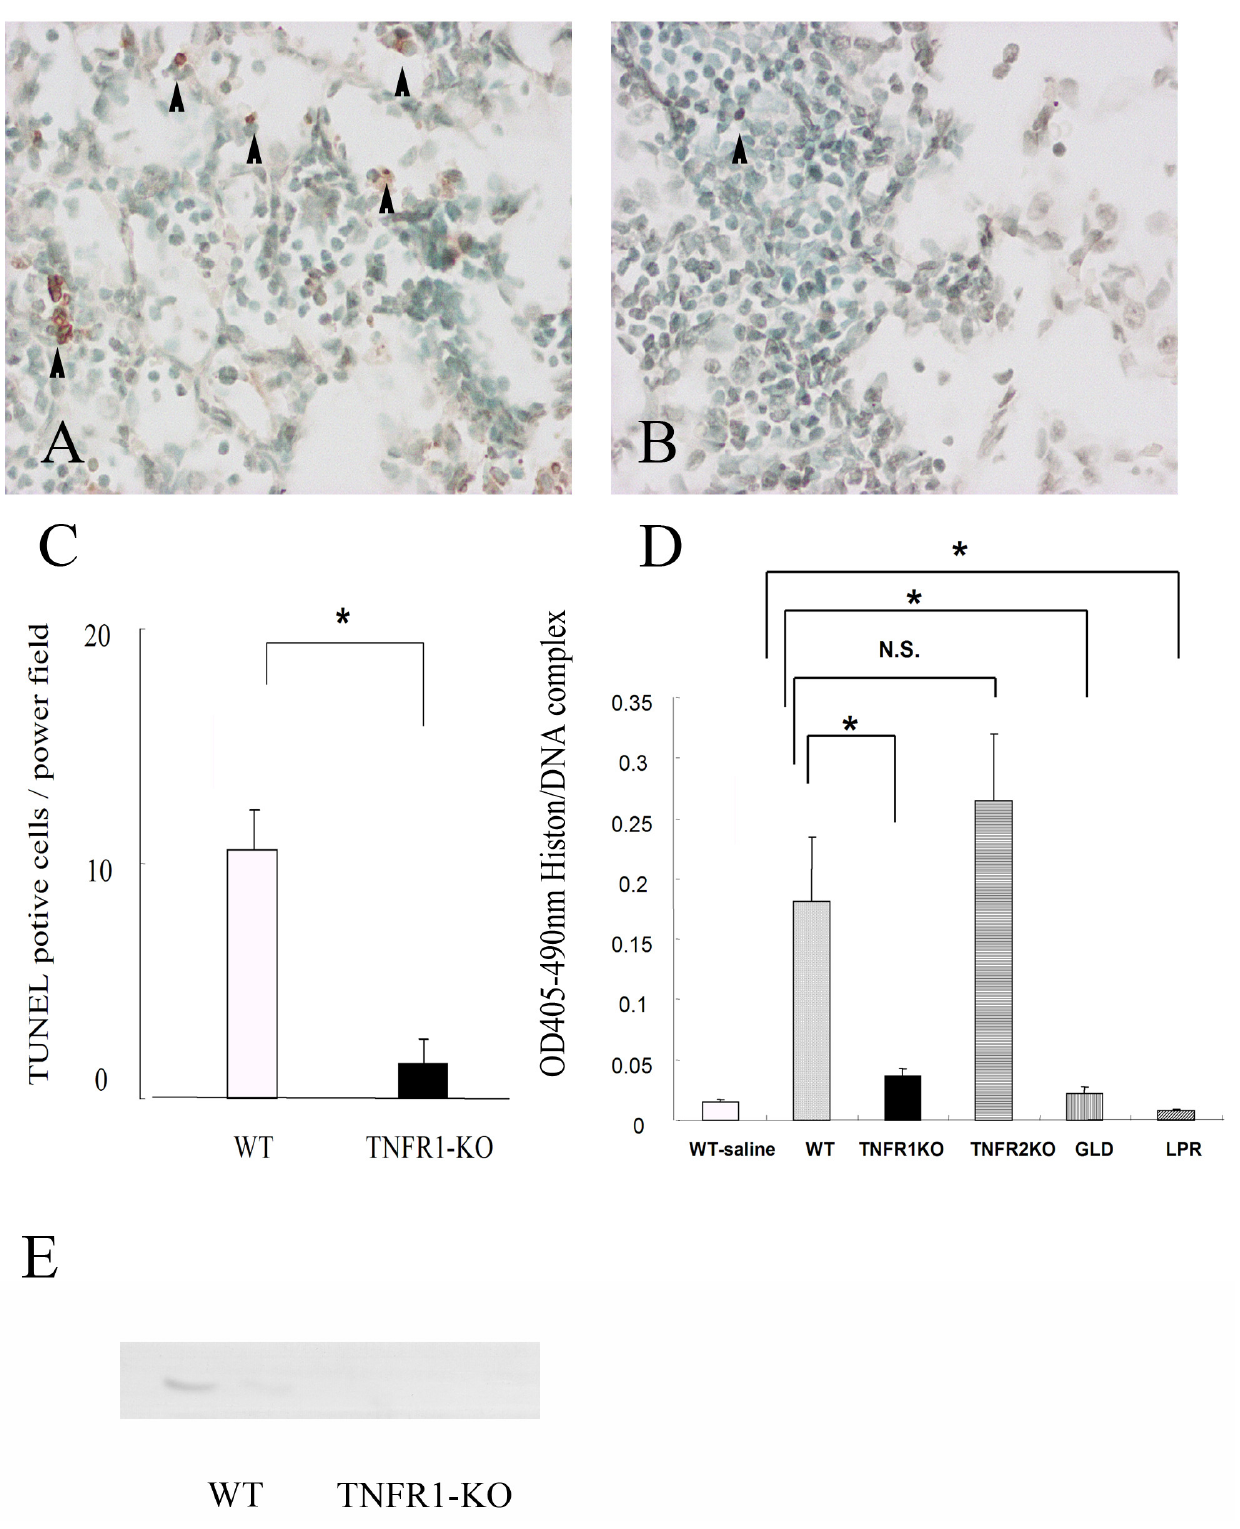
Figure 4. The effect of TNFR1 deficiency on terminal deoxynucleotidyl transferase mediated dUTP nick end labelling (TUNEL) staining in lung tissues after M. avium infection. ( A ) TUNEL positive cells are present in lung tissues from wild mice (C57BL/6) 21 days after M. avium infection. ( B ) There were fewer positive TUNEL signals (arrowheads) in TNFR1-KO mice. Original magnification, ×250. Arrowheads indicate TUNEL positive cell. ( C ) The effect of TNFR1 deficiency on the number of terminal deoxynucleotidyl transferase mediated dUTP nick end labelling (TUNEL) positive cells in M. avium infection in mice. Data are shown as the mean (SEM) obtained from five mice (* p < 0.01). ( D ) The effect of apoptosis-related gene deficiency on histone/DNA complexes in BAL fluids at day 21 after M. avium infection. WT-saline: wild-type (C57BL/6) mice administered saline, WT: wild type mice (C57BL/6) administered M. avium , TNFR1KO: TNFR1-KO mice administered M. avium , TNFR2KO: TNFR2-KO mice administered M. avium , lpr: lpr (Fas-KO) administered M. avium , gld: gld (FasL-KO) mice administered M. avium . High titers of histone/DNA complexes were observed in wild-type mice administered M. avium . Data are shown as the mean (SEM) obtained from five mice (* p < 0.01). N.S indicates no significance. ( E ) The expression of caspase-3 was measured by western blotting. Caspase-3 was strongly expressed at day 21 after M. avium infection in wild type mice (C57BL/6), but not in TNFR1-KO mice.